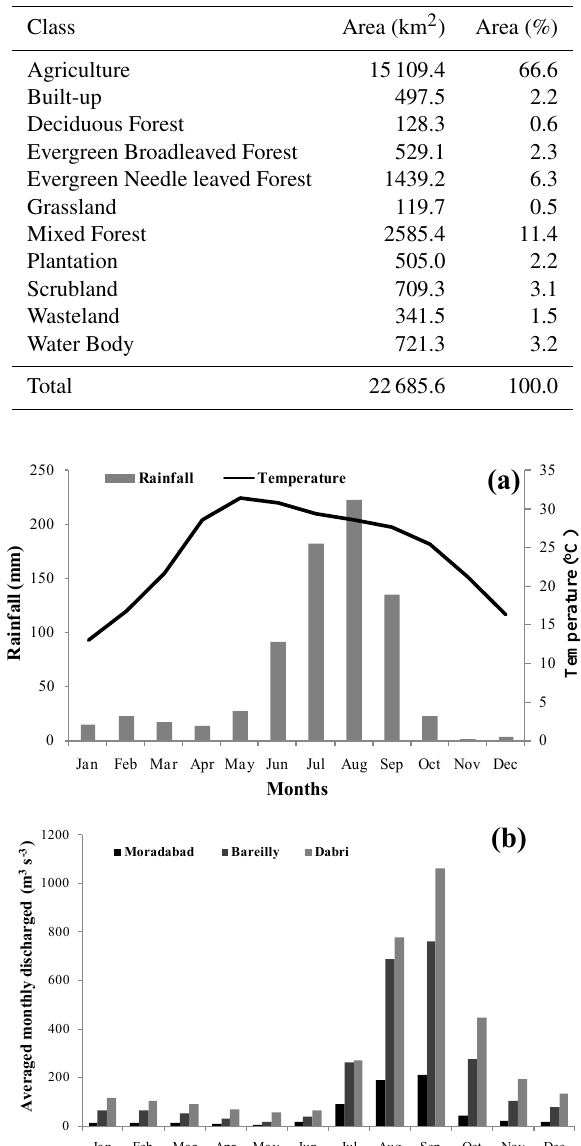
Table 1. Land Use and Land Cover area of Ramganga Basin.